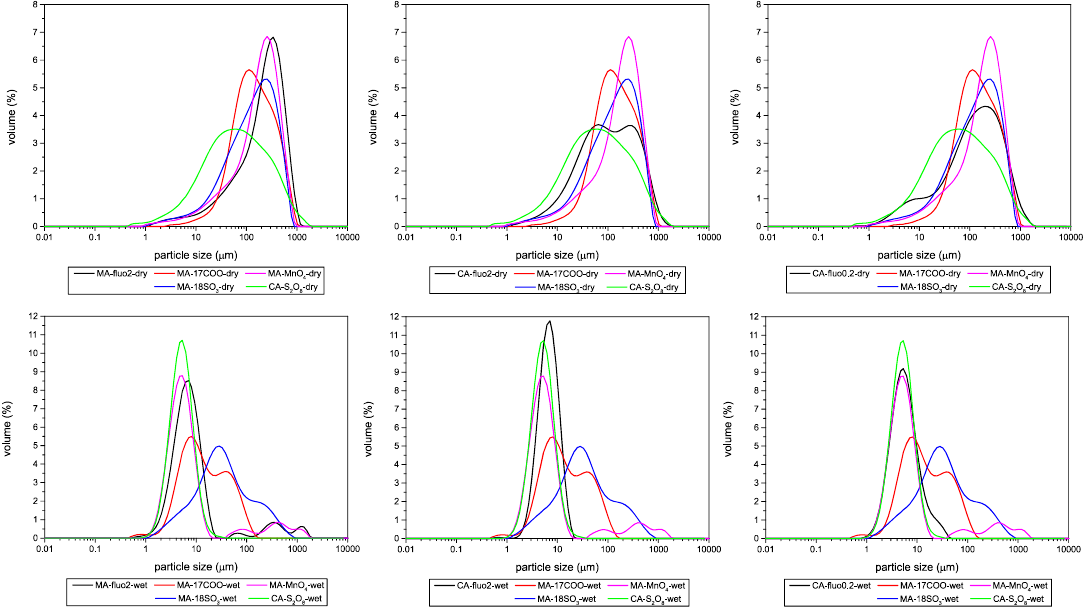
Figure 8. Comparative study of the particle size distribution of the dried sample material (upper panel) and wet sample material (lower panel) of previously studied Layered Double Hydroxides (LDHs) with fluorescent particles (left panel: MA-fluo2; middle panel: CA-fluo2, right panel: CA-fluo0.2).